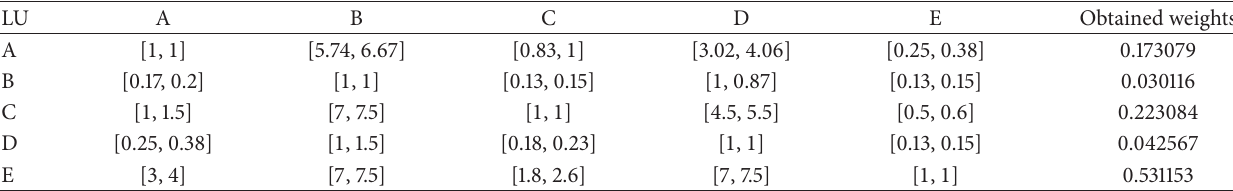
Table 15: The interval approximation choices referring to LU subcriteria.